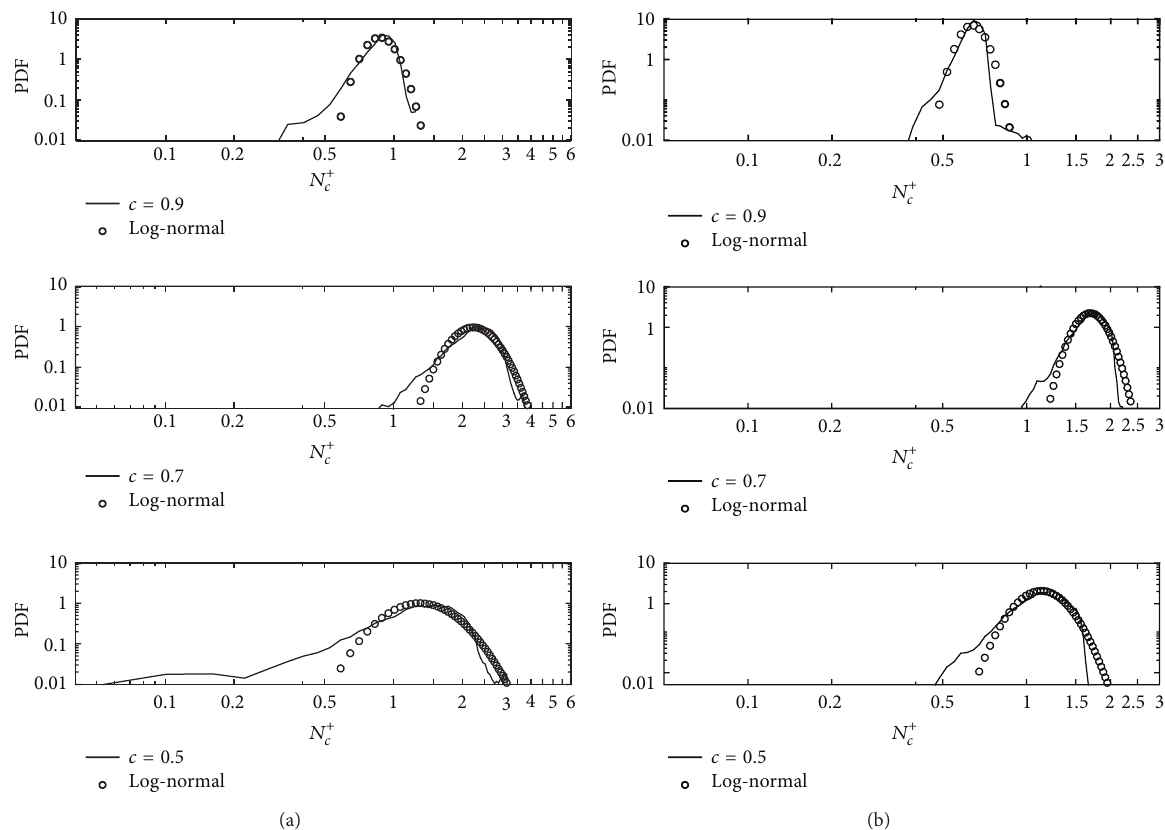
/𝑆 𝐿 ) and the log-normal distribution in log-log scale for th